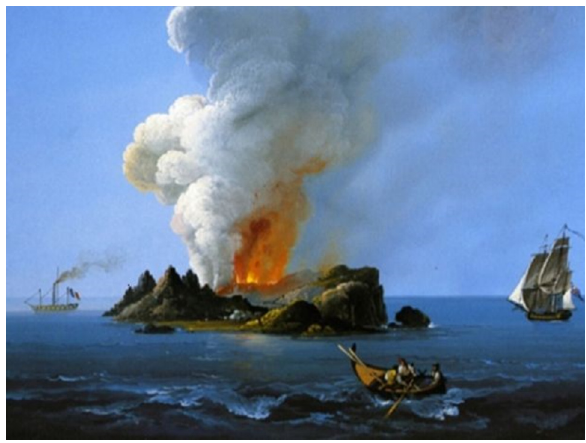
Figure 2. One of the several paintings by the French painter Edmond Joinville showing the 1831 eruption forming Ferdinandea Island.